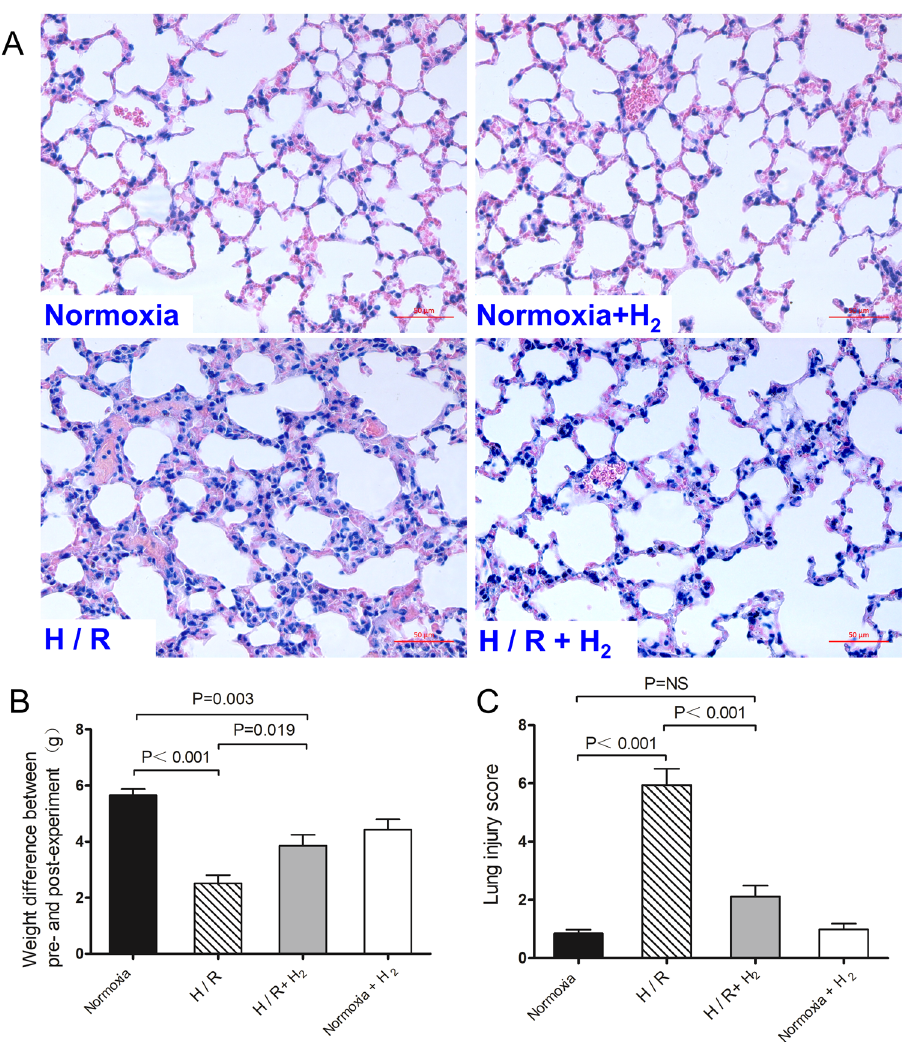
Figure 1. Hydrogen inhalation reduced H/R-induced lung injury. Mice were exposed for 4 weeks (8 h per day) to hypoxia, hypoxia with 4% H 2 or normoxia with 4% H 2 and then housed in normoxia (16 h per day). Control mice were housed in normoxia (n = 10 in each group). ( A ) Hematoxylin-eosin staining of lung tissues. ( B ) Change in weight between before and after the experiment. ( C ) Lung injury scores. Scale bar, 50 μ m. Data shown are mean ± SEM. ns, not